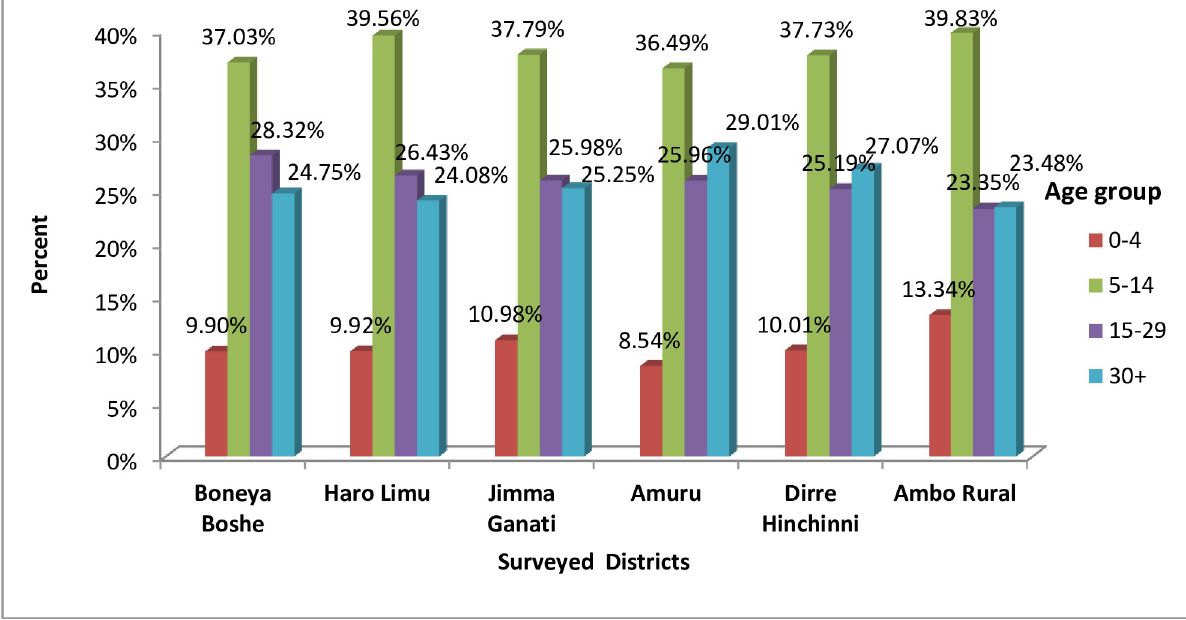
Fig 4. Proportion of respondents swallowed drugs by age group, mass drug administration for Trachoma coverage survey in six districts in East Wollega, Horroguduru Wollega and West Shewa zones, 2017.